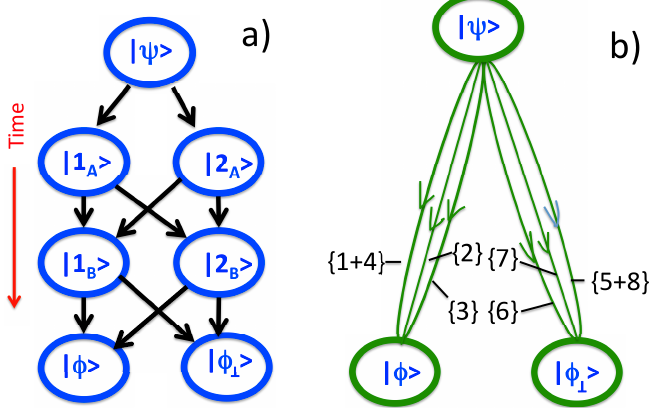
Figure 3. ( a ) Eight virtual paths connecting the initial state of a two-level system, | ψ (cid:105) , with its final state | φ (cid:105) , and its orthogonal compliment | φ ⊥ (cid:105) ; ( b ) real paths produced in an accurate measurement of the functional F 2 in Equation (16), which takes the values − 2, 0 and